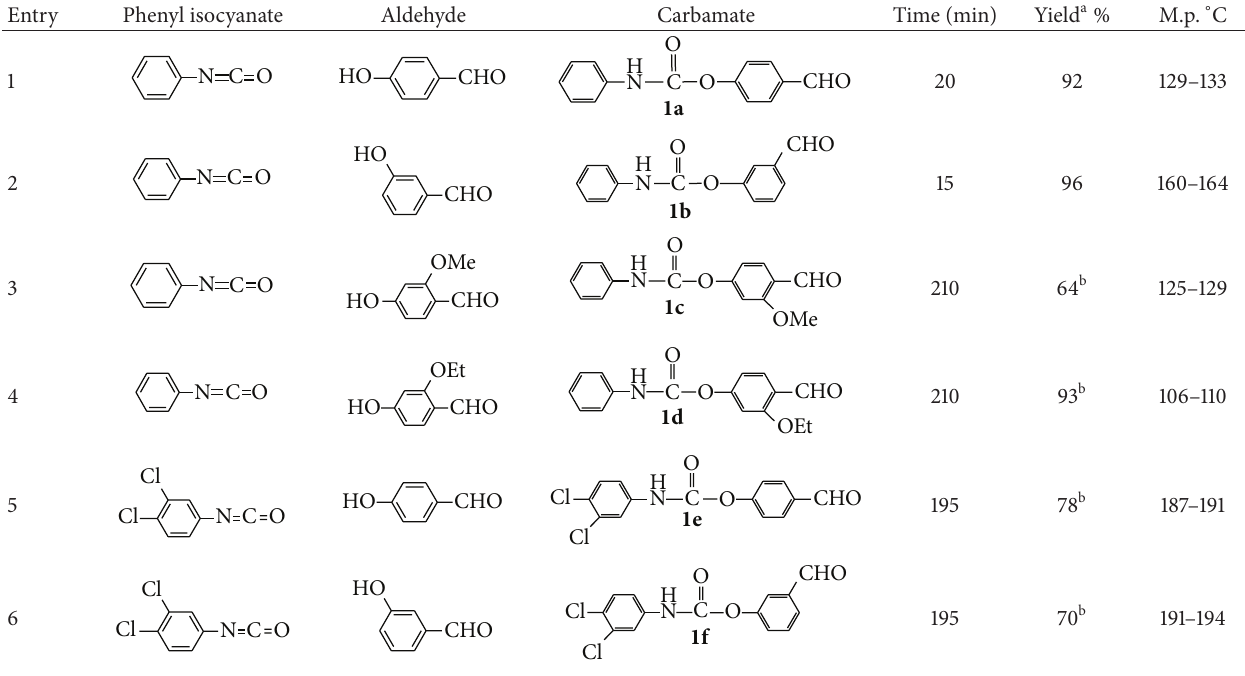
Table 1: Synthesis of various carbamate derivatives ( 1 a – f